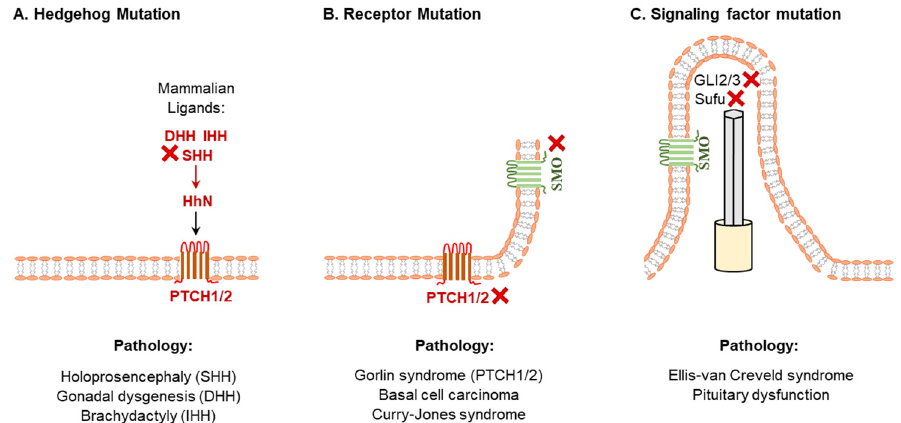
Figure 2. Diseases due to abnormal hedgehog signaling. Mutations in HH coding sequence ( A ), HH receptors ( B ) or mutations in the downstream signaling molecules ( C ) of HH signaling result in various pathological conditions. In the lower panels, a selected group of common pathological conditions are indicated under the corresponding mutations.